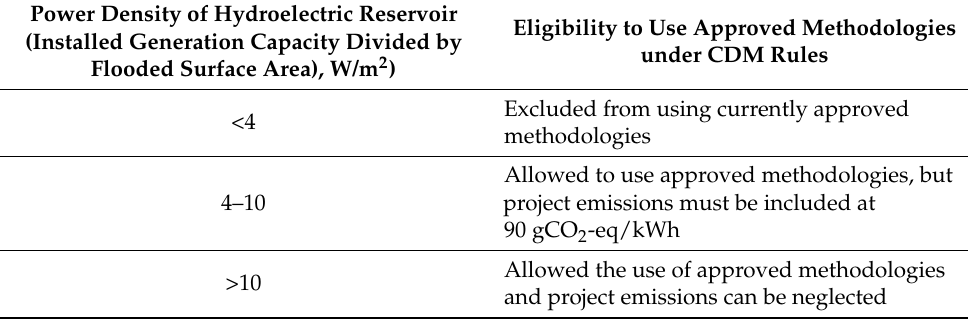
Table 5. Restrictions on hydropower projects under the CDM